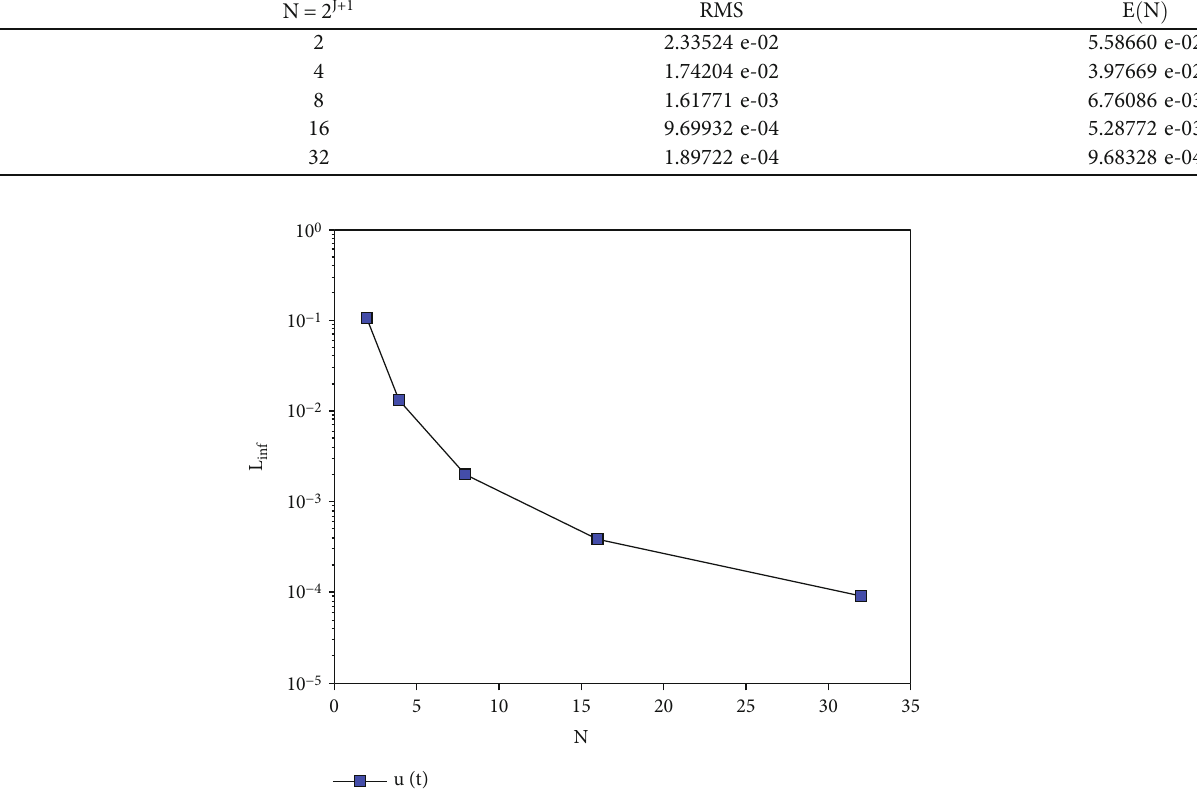
Figure 3: E(N) errors for di ff erent mesh points of Example 3. Table 4: RMS and E ð N Þ errors for Example 4.